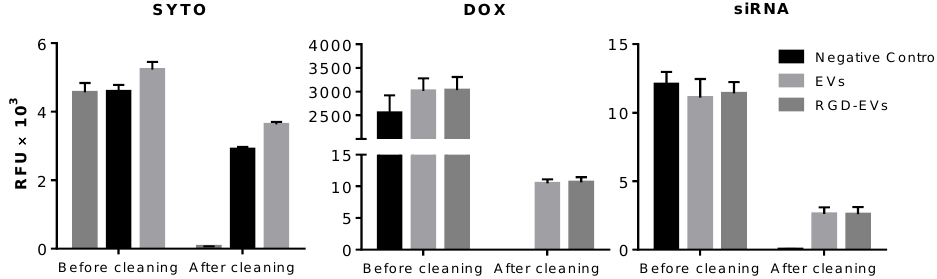
Figure A3. Fluorescence intensity measurements in EV during labelling and drug-loading proce- dures.